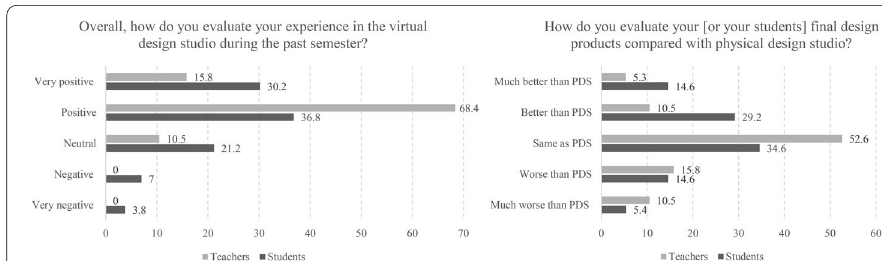
Fig. 3 Left, overall evaluation of VDS experience; right, evaluation of final design outcomes. The reported numbers are actual percentages (rounded up) and include missing answers, if